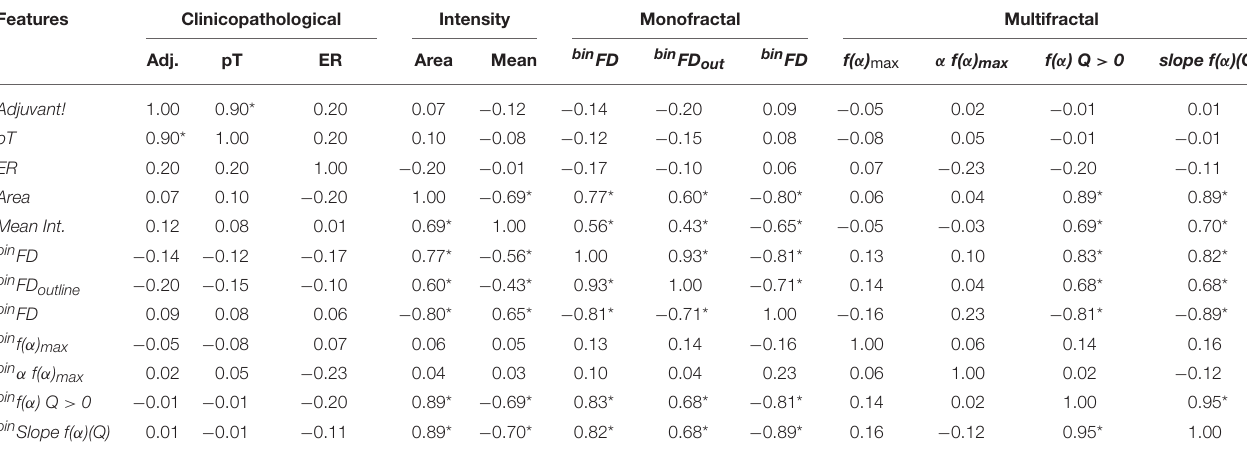
TABLE 3 | Correlations between the prognostically significant clinicopathological, intensity and fractal features. Features Clinicopathological Intensity Monofractal Multifractal